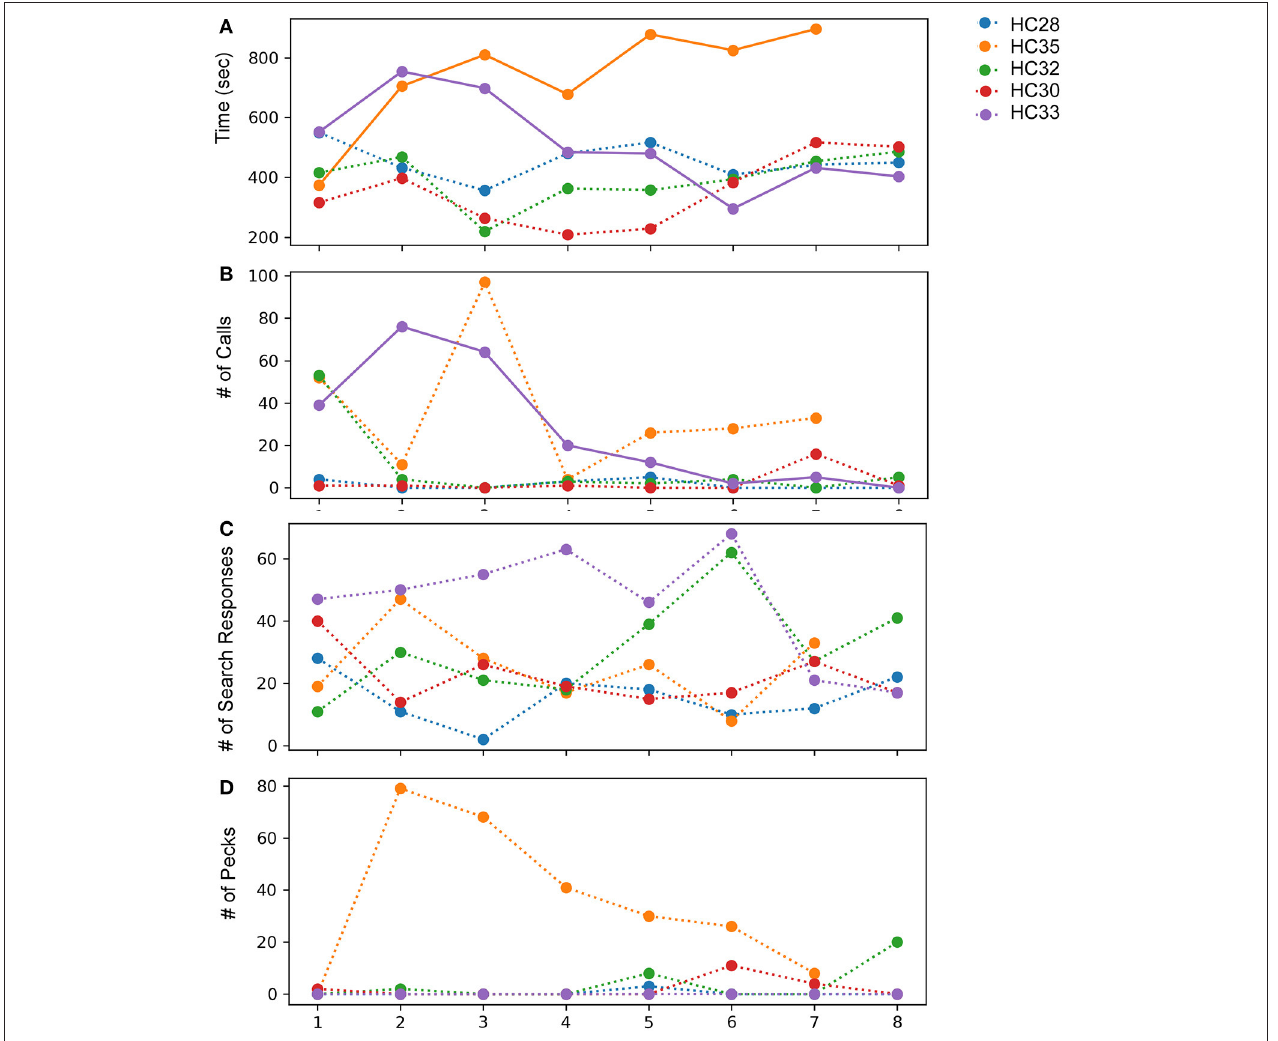
FIGURE 7 | Effects of observing mirror images in adult house crows across eight successive sessions of the mirror exposure phase. (A) Time spent while facing the mirror, (B) number of calls produced while facing their reflections, (C) number of search responses (looking behind the mirror and turning clockwise or anticlockwise) while facing the mirror, and (D) number of pecks on the surface or sides of the mirror, indicating aggressive behavior. Colors indicate different crows used for the experiment, bold lines indicate significantly increasing or decreasing linear trends ( P < 0.05; paired t -test) as trials progressed and dotted lines represent no significant differences for different behaviors